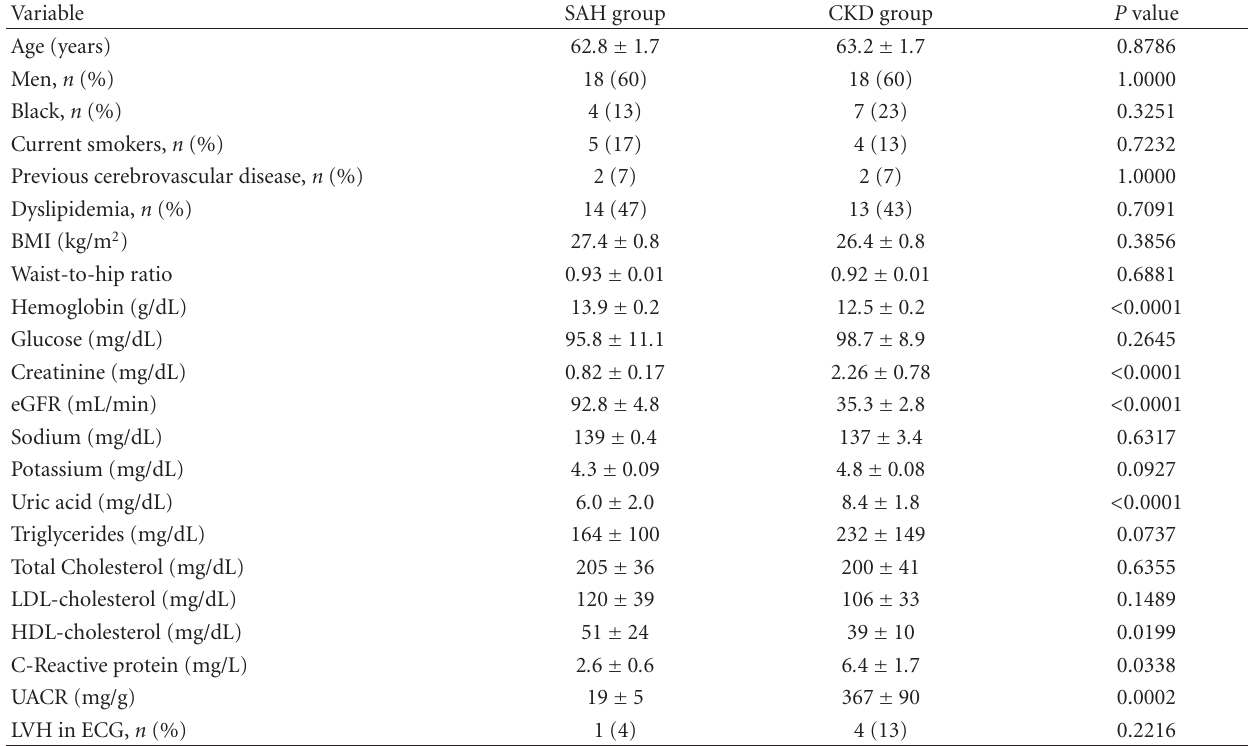
Table 1: Demographic, anthropometric, and laboratory data of hypertensive patients in both groups.